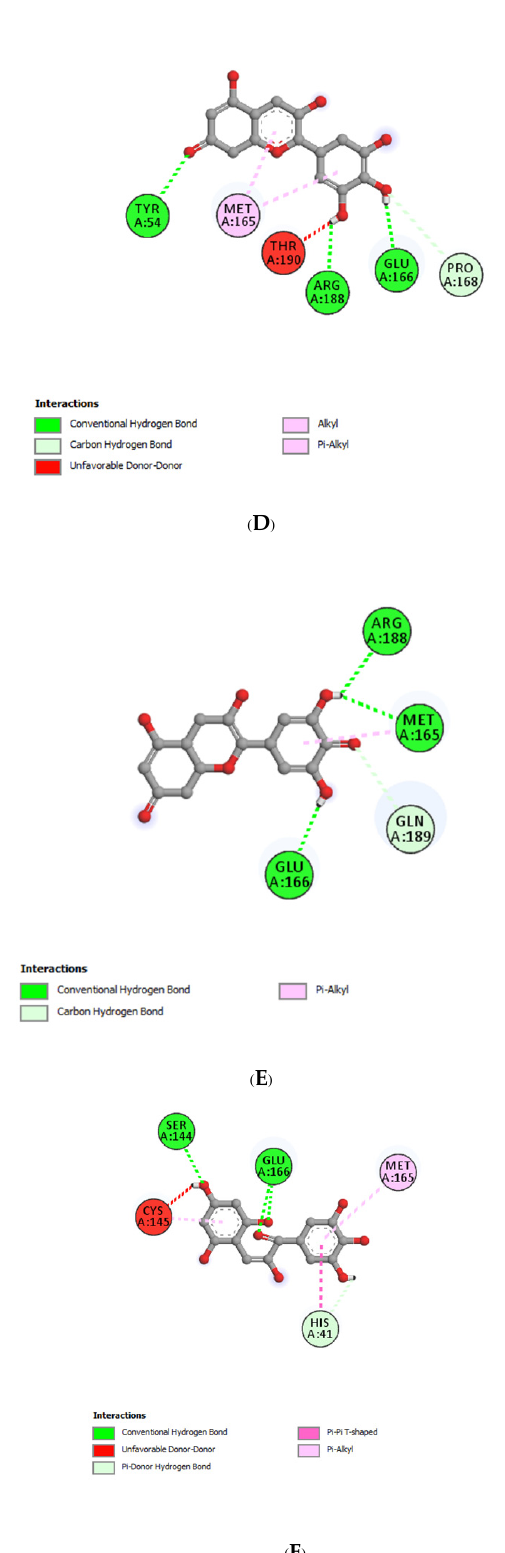
Figure 4 . ( A ) Interaction of delphinidin ( PubChem structure ) with Mpro ( without N3 ). ( B ) Interaction Figure 4. ( A ) Interaction of delphinidin (PubChem structure) with Mpro (without N3). ( B ) Interaction of delphinidin ( hemiacetal form ) with Mpro ( without N3 ). ( C ) Interaction of delphinidin ( hemiketal of delphinidin (hemiacetal form) with Mpro (without N3). ( C ) Interaction of delphinidin (hemiketal form ) with Mpro ( without N3 ). ( D ) Interaction of delphinidin ( quinonoid 1 form ) with Mpro ( without form) with Mpro (without N3). ( D ) Interaction of delphinidin (quinonoid 1 form) with Mpro (without N3 ). ( E ) Interaction of delphinidin ( quinonoid 2 form ) with Mpro ( without N3 ). ( F ) Interaction of N3). ( E ) Interaction of delphinidin (quinonoid 2 form) with Mpro (without N3). ( F ) Interaction of delphinidin ( chalcone form ) with Mpro ( without N3 ). delphinidin (chalcone form) with Mpro (without